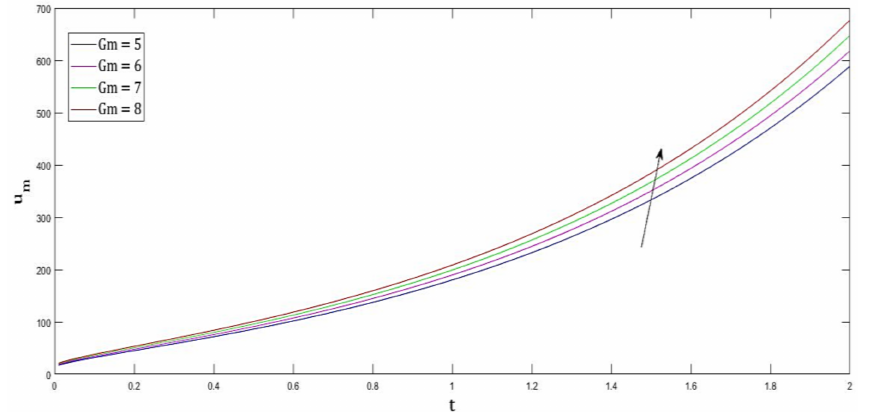
Figure 15. Variation in skin friction with respect to mass Grashof